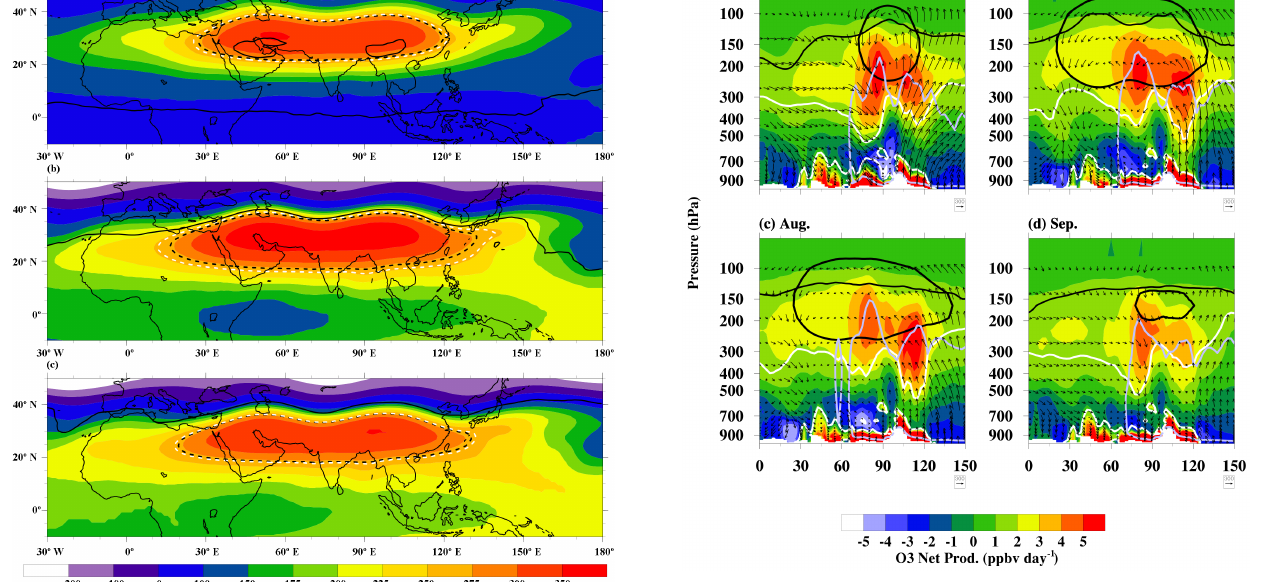
Figure 8. Geopotential heights (GH) from MERRA for July 2009 at (a) 100, (b) 150hPa and (c) 200hPa. The black dotted lines represent the GH isocontours at (a) 16770m, (b) 14350m and (c) 12520m and the white dotted line represents the 270m GH anomalies (see text for details).